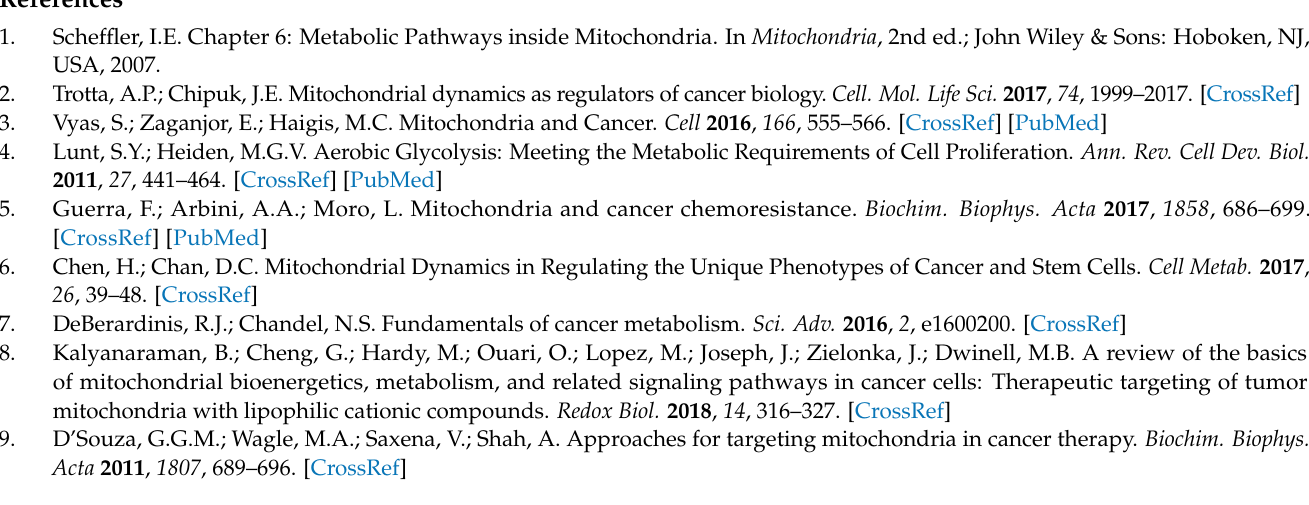
are the overlaid images, with colocalized pixels represented in white color. Scale bars represent 10 µ m.; Figure S28. FLIM imaging of compound 3 in MDA-MB-231 cells. The images show the fluorescence lifetime of 3 depicted on a pseudocolor scale between 3 and 6 ns. The leftmost column of images shows colocalized pixels with mitochondria. The central column of images shows non colocalized pixels. The rightmost column of images shows the overall images. Scale bars represent 10 µ m. The plots on the right panels represent the pixel distribution of fluorescence lifetime of 3 in each image, localized in mitochondria (black lines) or in other cellular subcompartments (red lines), and the overall lifetime distribution (green lines).; Figure S29. Representative dual-color FLIM images of compound 4 in 143B ( A , C , and E ) and ρ 0206 cells ( B , D , and F ), after 20 min of incubation with MT. In the FLIM images ( A and B ), the dye’s detection channel (left) and the MT detection channel (right) are shown separately. The colocali-zation images ( C and D ) of the dye (green) and MT (red) are also shown. Intensity traces in both channels (E and F) are shown for the depicted lines in the colocalization panels. Scale bars represent 10 µ m.; Table S2. Pearson’s correlation coefficient (PCC) and Manders’ colocalization coefficient (MCC) values for the colocalization of dyes 1–4 with the mitochondria tracker MT.[a].; Figure S30. Representative dual-color fluorescence images of compound 1 (green) and the MT tracker (magenta) in 143B cells after 20 min of incubation with BAM15. Scatter plots represent the corre-lation of the intensity values in the green channel vs the red channel. Scale bars represent 10 µ m.; Figure S31. Cell viability of SKBR3 breast cancer tumor cells treated with 2-(3-thienyl)ethanol at different doses. Error bars represent standard deviations. Line represents the fit to a dose-response